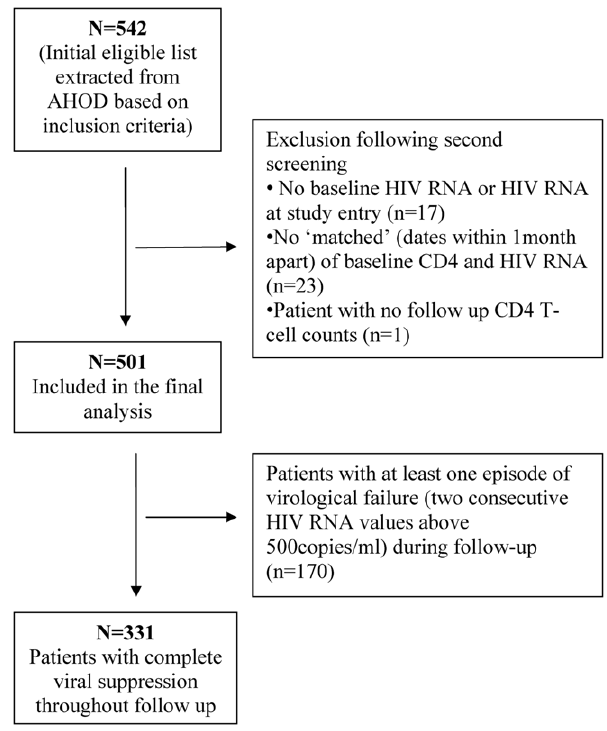
Figure 1. Patient disposition.